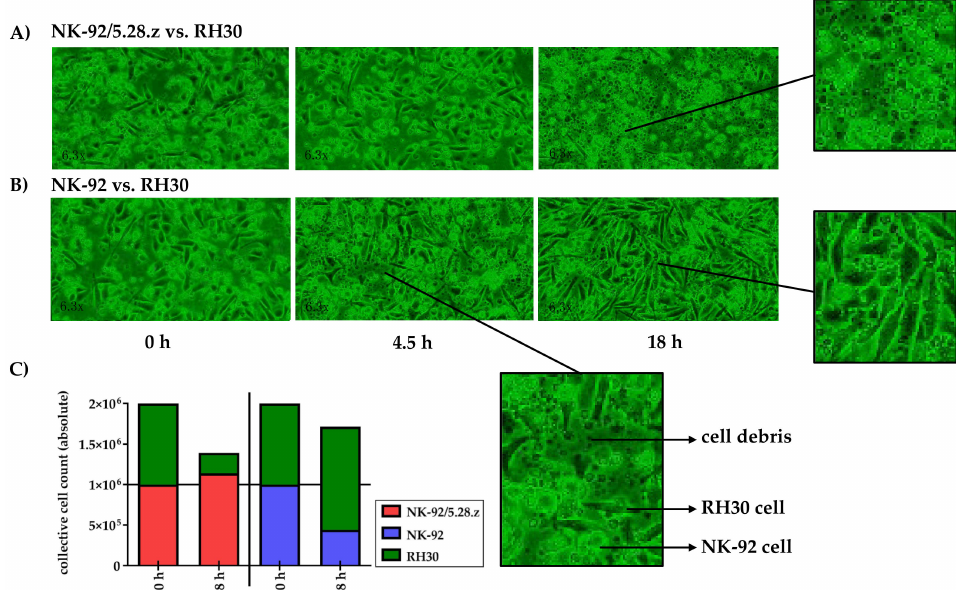
Figure 4. Time-lapse microscopy analysis of NK-92/5.28.z cell activity over 18 h. Images of established RH30 cell monolayers were recorded during coincubation with NK-92/5.28.z ( A ) or parental NK-92 ( B ) cells ( n = 1). NK-92/5.28.z cells proliferated and almost completely lysed RH30 cell monolayers, while NK-92 cells decreased in number and were not able to lyse RH30 cell monolayers or inhibit tumor growth. The observed effects are shown as exact cell counts ( C ). Here target and effector cells were discriminated by their different microscopic morphology as well as by their different culture behaviors (see Section